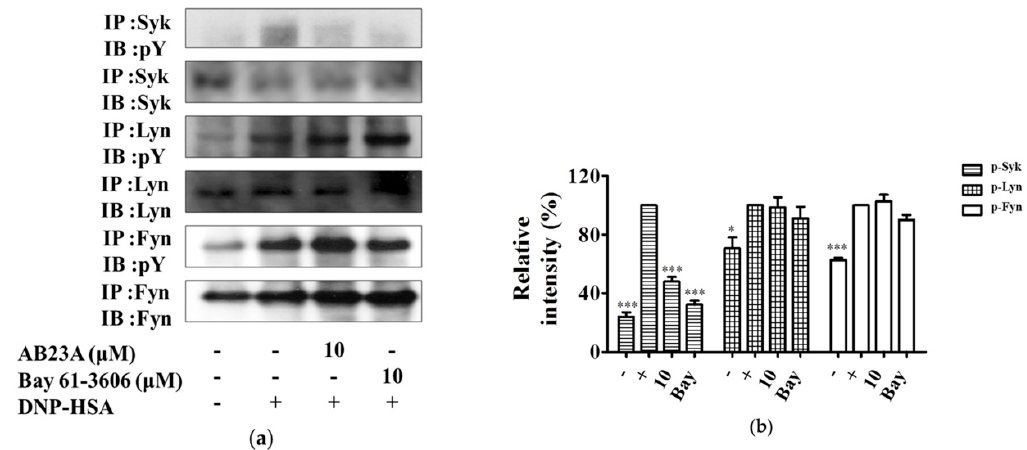
Figure 4. AB23A suppresses the Syk-associated pathway. ( a ) IgE-sensitized BMMCs were pre-incubated with AB23A or Bay 61-3606 for 1 h and then stimulated with DNP-HSA for 5 min. Cell lysates were subjected to immunoprecipitation and immunoblot analysis for the phosphorylated forms of Syk, Lyn, and Fyn. ( b ) The relative ratios of Syk, Lyn, and Fyn proteins were determined by analyzing immunoblot band intensities. The data show the mean ± SEM of three independent experiments. ANOVA, p < 0.0001 (p-Syk), p < 0.05 (p-Lyn), p < 0.001 (p-Fyn), post hoc * p < 0.05 and *** p < 0.001, compared with the cells stimulated with IgE/Ag in the absence of